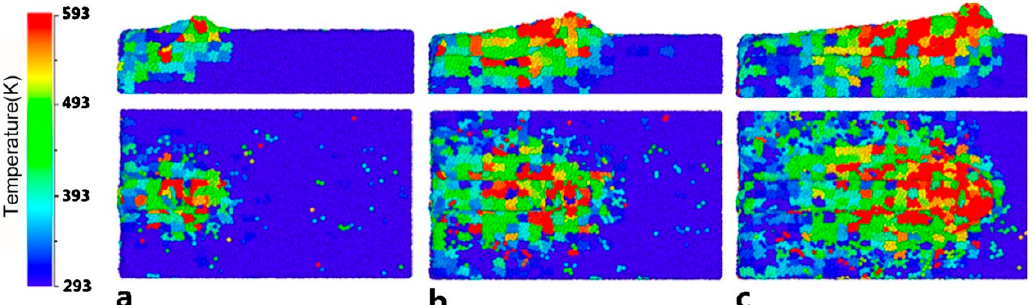
Figure 17. The cutting regional temperature variation diagram of the workpiece during the nano- metric cutting process, ( a – c ) are cross-section views of x–z plane (the first row) and vertical views (the second row), showing the cutting regional temperature variation at cutting distances of 4, 8, and 14 nm, respectively, reprinted with permission from Ref. [48] 2014, Elsevier.